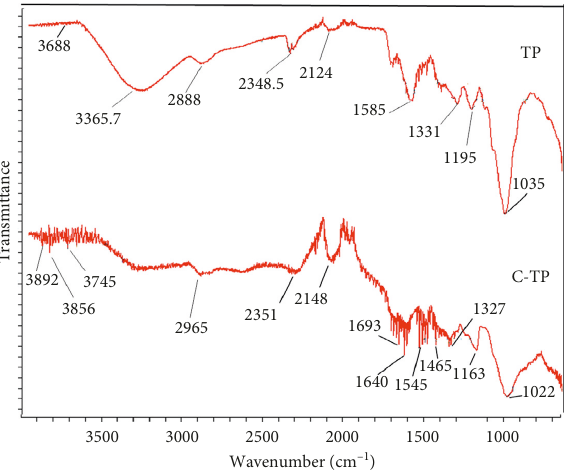
Figure 5: A comparative FT-IR analysis of native (TP) and citric acid-modified (C-TP) Trapa natans